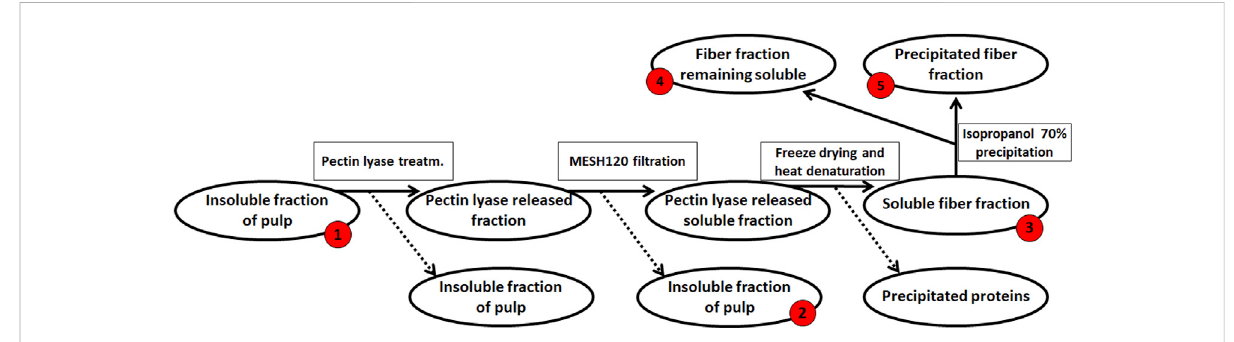
FIGURE 2 Enzymaticextractionofpectin-richpolysaccharidesfromde-starchedsweetpotatoprocessingpulp.Therednumbersindicatethefractionfor whichmonosaccharidecompositionsweredetermined,from# ‘ s1 – 5.The fi nalextract(2.8 g)wasresuspendedin200 mlddH 2